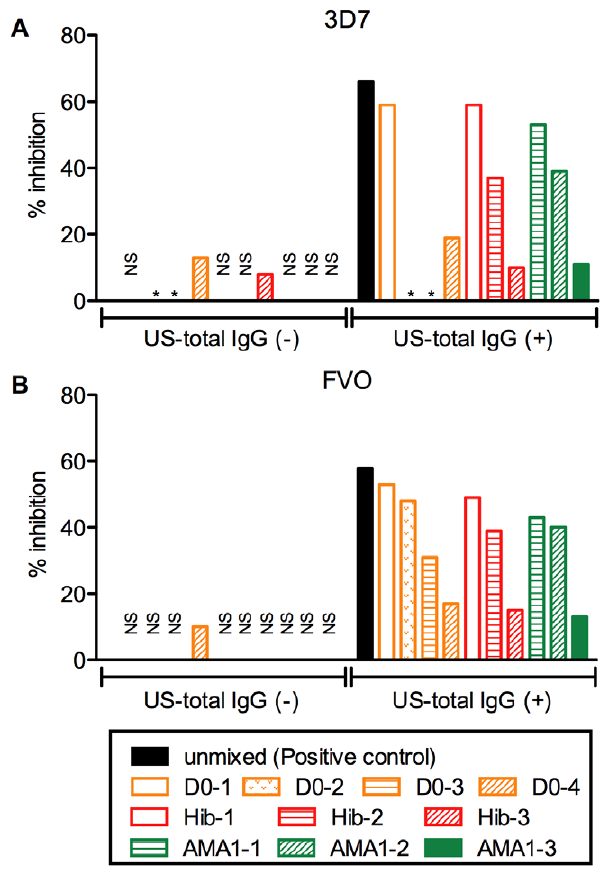
Figure 3. Non-AMA1 IgGs from Malian children reduce the growth-inhibitory activity of US-total IgG. (A) Four mg/ml of non- AMA1(3D7) IgGs were tested either by themselves (left side) or with US- total IgG (right side) using P. falciparum 3D7 parasites. The US-total IgG was tested alone as a positive control (black bar) (B). Similar study was performed using non-AMA(FVO) IgGs and P. falciparum FVO parasites. NS: % inhibition was in the range of 6 5%. *: no non-AMA1 IgG was made in this